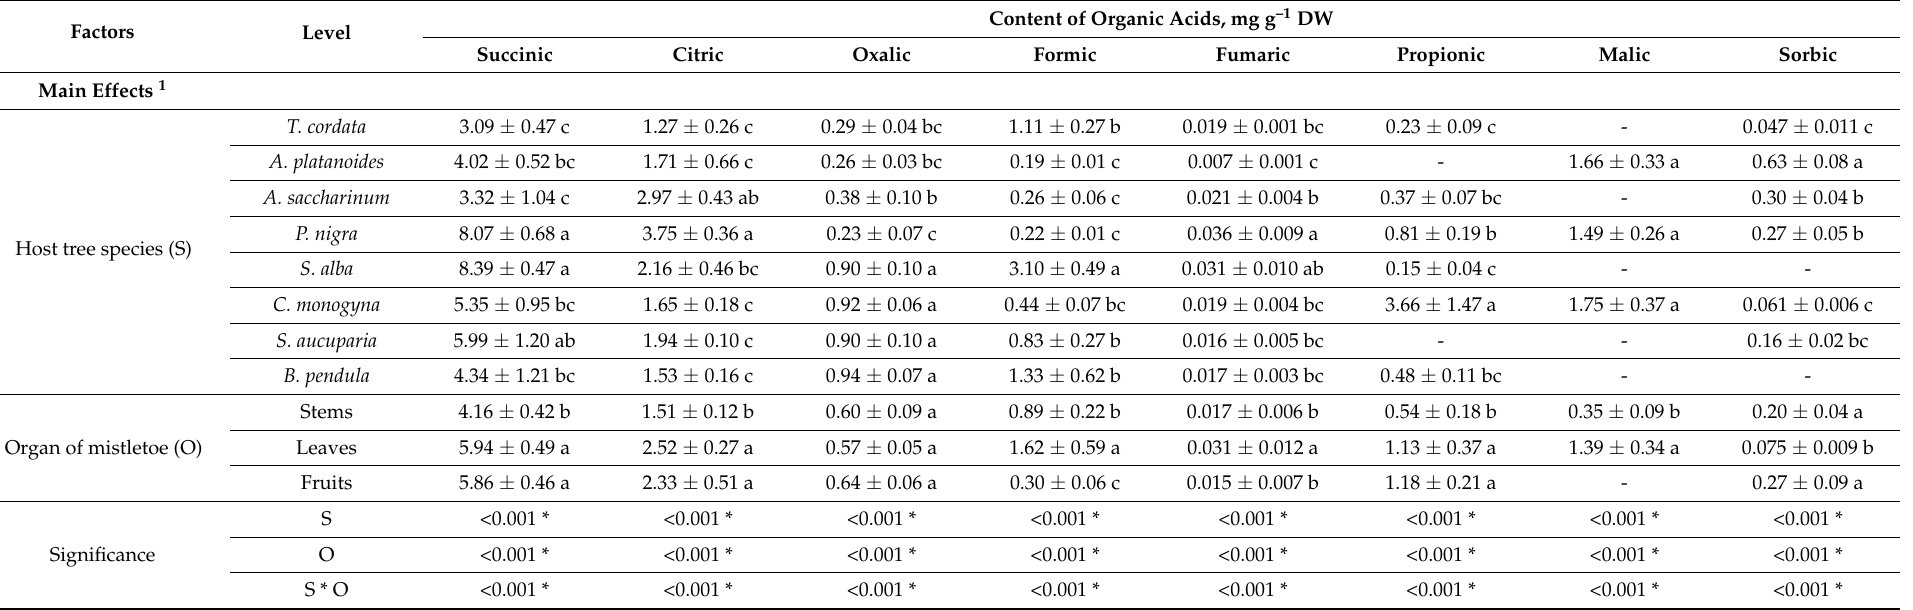
Table 4. Content of organic acids in mistletoe depending on host tree species and type of mistletoe